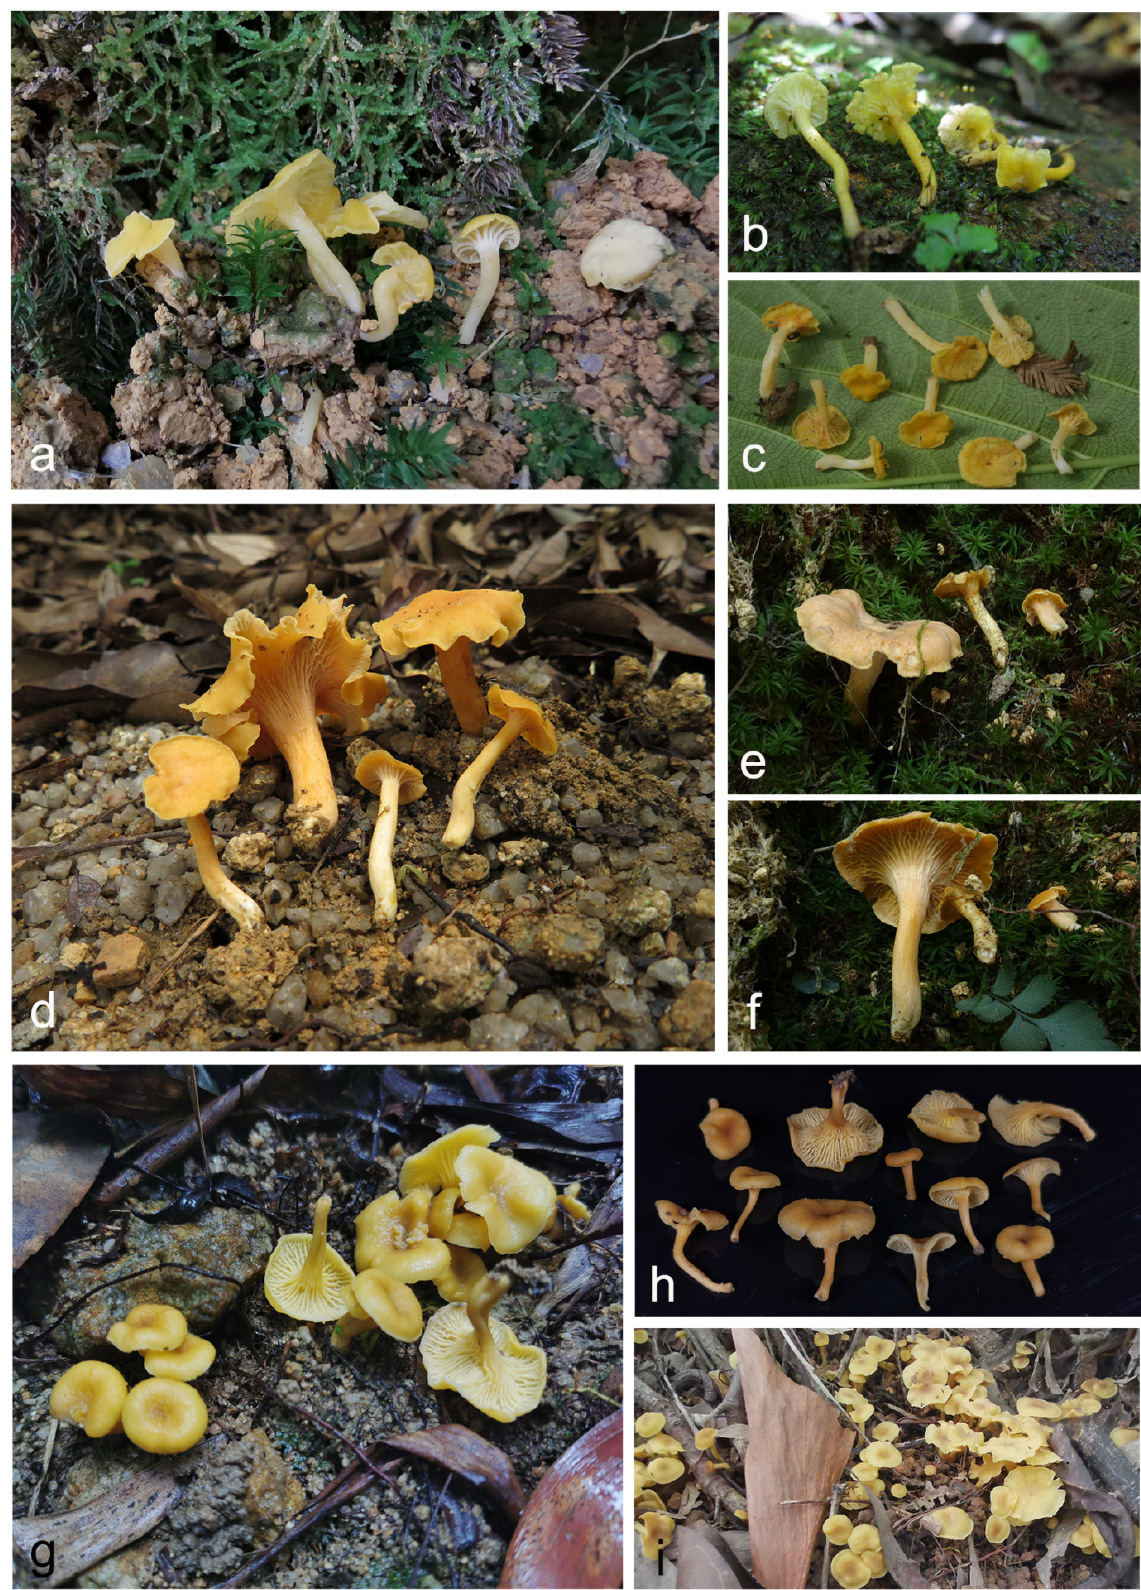
Figure 7. Species of Cantharellus subg. Parvocantharellus from China. ( a – c ) C. galbanus ( a ) GDGM86429 holotype! ( b ) GDGM43100; ( c ) GDGM60568); ( d – f ) C. luteolus ( d ) GDGM60393 holotype! ( e , f ) GDGM86247); ( g–i ) C. luteovirens ( g , h ) GDGM80672 holotype! ( i ) GDGM81079.